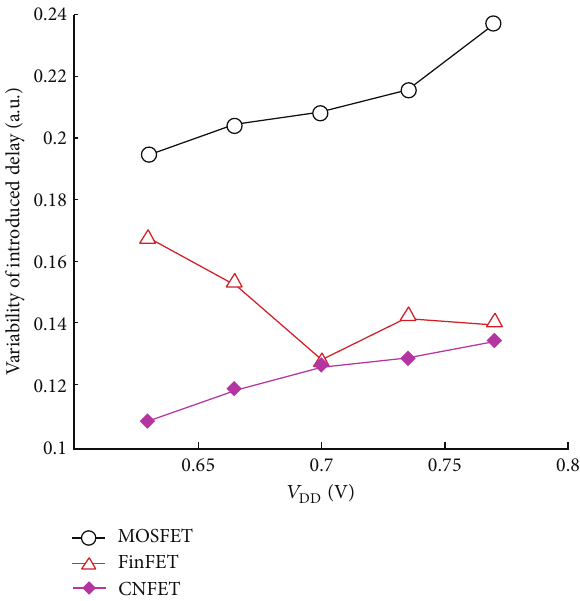
Figure 12: Variability analysis of the introduced delay by the proposed buffered delay circuit for various supply voltages.